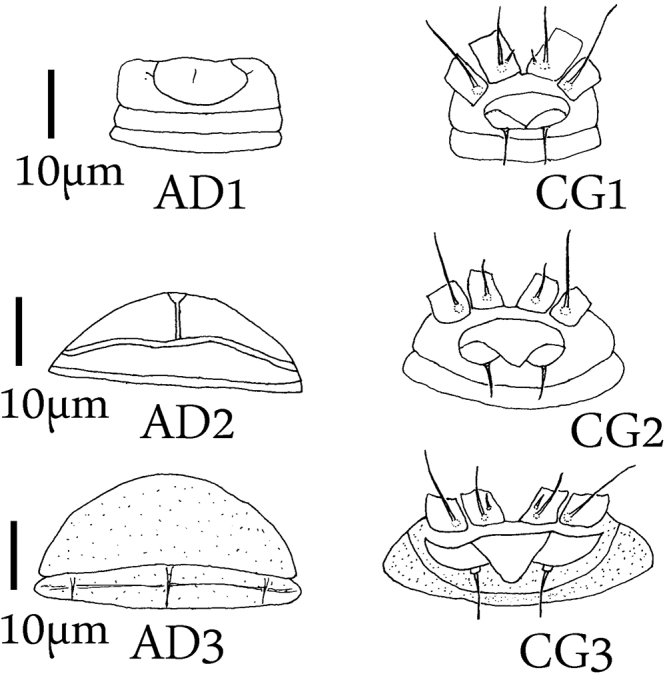
Female: Antero-dorsal region AD and coxigenital region CG AD1 and CG1 of AshieldophyespennadamensisAD2 and CG2 of BrevishieldophyesglochidionaeAD3 and CG3 of Mesoshieldophyesvarecae.